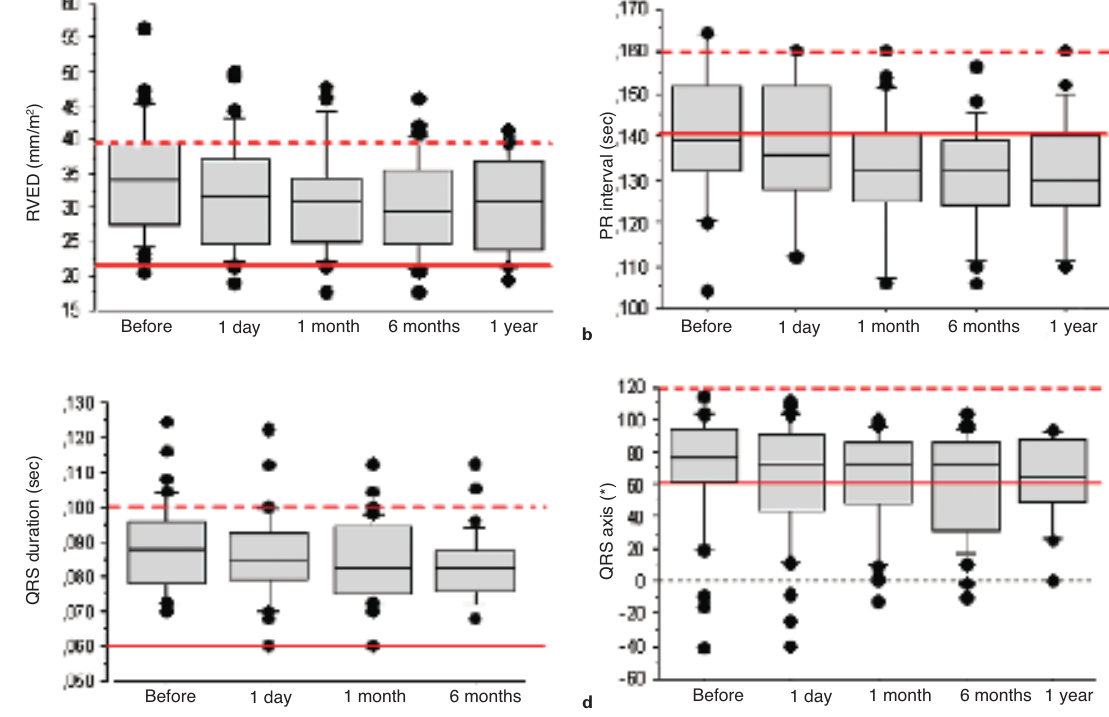
a. Box plot (median, IQR) demonstrating the evolution of the dimension of the end-diastolic diameter of the right ventricle indexed to the body surface area between before intervention and measures after intervention. Continuous line: mean normal value for the population, dashed line: 2SD of the normal value. Normal value retrieved from two publications [15–16] that have analysed a total of 160 normal children and adolescents. b. Box plot (median, IQR) demonstrating the evolution of the PR interval between before intervention and measures after intervention. Continuous line: mean normal value for the population, dashed line: 2SD of the normal value. Normal value retrieved from the publication of Davignon et al., that have analysed 2400 normal infants, children and adolescents [18]. c. Box plot (median, IQR) demonstrating the evolution of the QRS duration between before intervention and measures after intervention. Continuous line: mean normal value for the population, dashed line: 2SD of the normal value. Normal value retrieved from the publication of Davignon et al., that have analysed 2400 normal infants, children and adolescents [18]. d. Box plot (median, IQR) demonstrating the evolution of the QRS axis between before intervention and measures after intervention. Continuous line: mean normal value for the population, dashed line: 2SD of the normal value. Normal value retrieved from publication of Davignon et al., that have analysed 2400 normal infants, children and adolescents